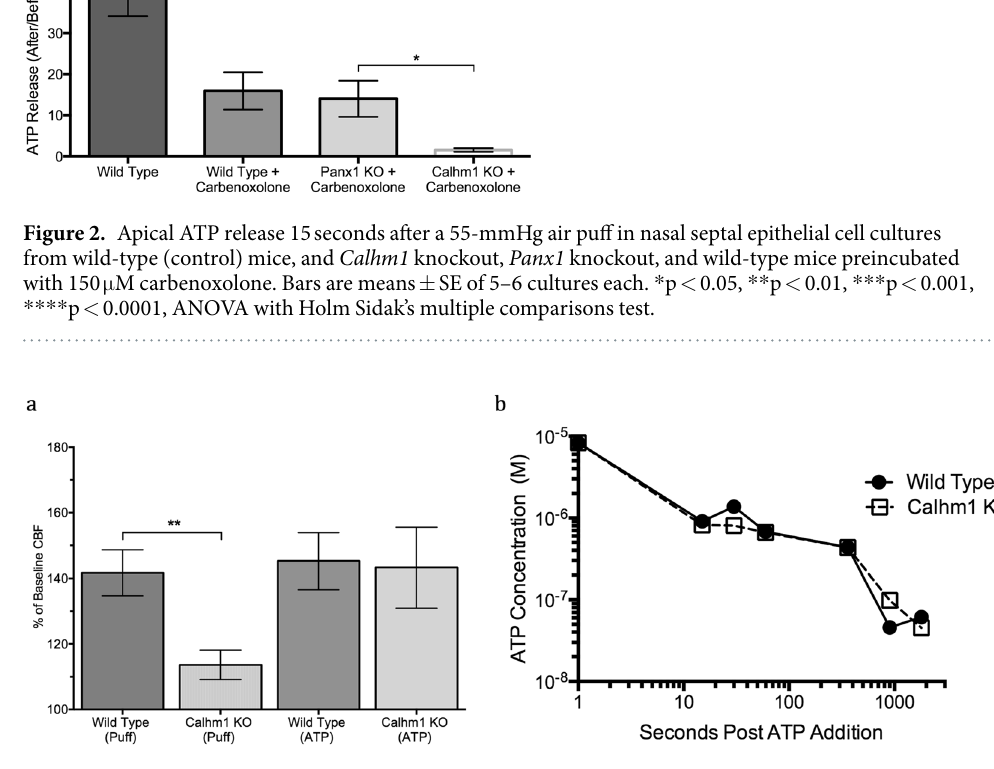
Figure 3. ( a ) CBF Increases 15 seconds after 1- μ M ATP addition or 55-mmHg air puff in nasal septal epithelial cell cultures from Calhm1 knockout and wild-type mice. Bars are means ± SE of 3–6 cultures each. ( b ) ATP degradation in Calhm1 knockout wild-type mice. 5 × 10 − 7 M ATP was added to the apical surface t = 0, and apical ATP concentration was measured at six distinct time intervals following this addition. All Apical ATP concentrations are adjusted for a 3.6 μ l ASL